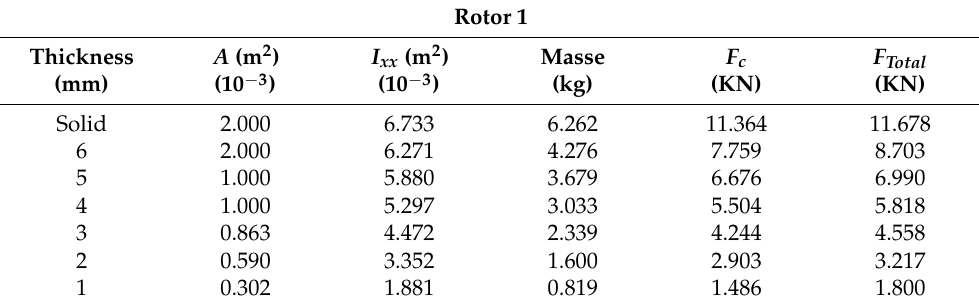
Table 4. Displacements and maximum stresses for different values of the thickness and mass of the rotor blade 1.